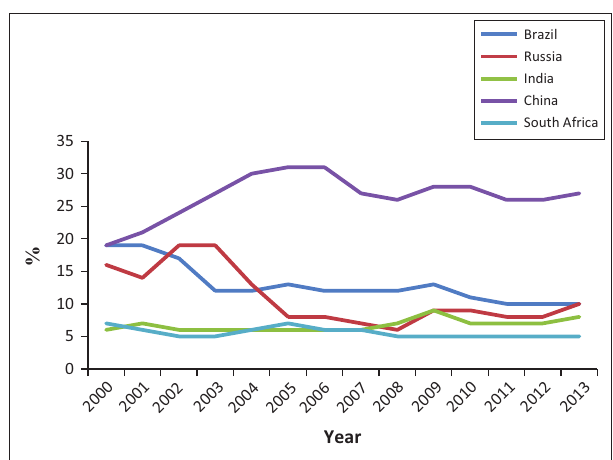
FIGURE 2: High-tech exports as a percentage of manufacturing